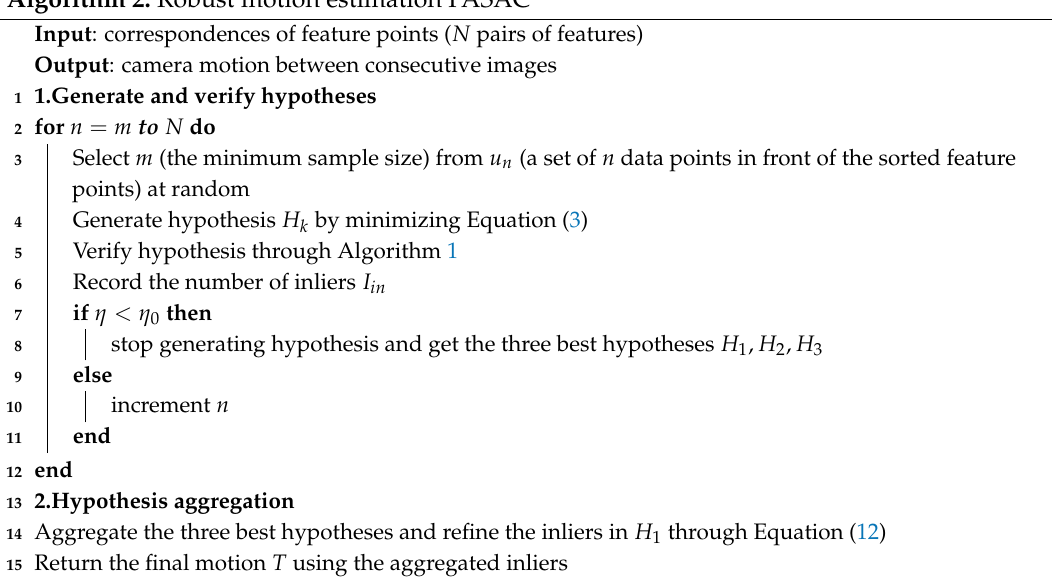
Algorithm 2: Robust motion estimation PASAC